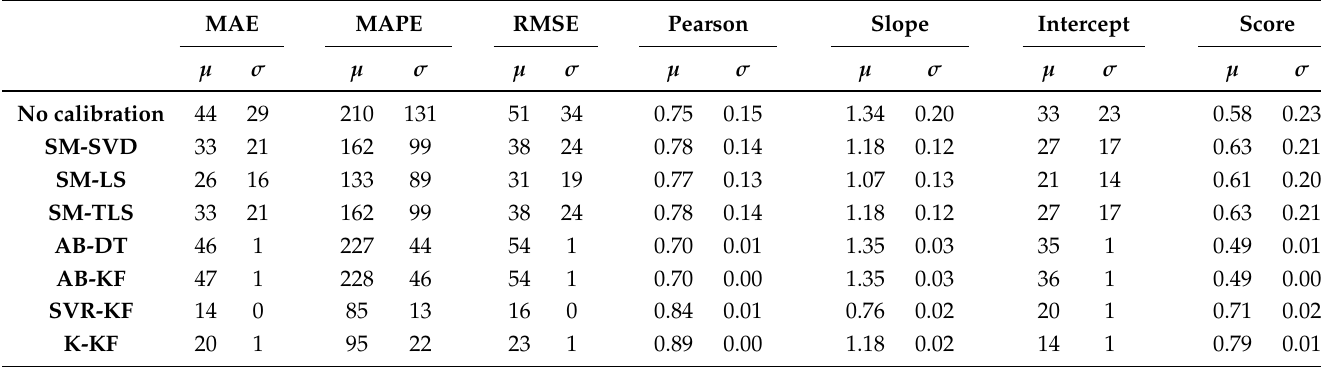
Table 12. Mean and standard deviation of each metric, computed on the entire time interval of study, over the 16 nodes of the network with the CGOI drift model. Results are very different with this model compared to Tables 1 and 4, notably for SM-(SVD, LS, TLS) even if we take into account that we expected to have incorrect